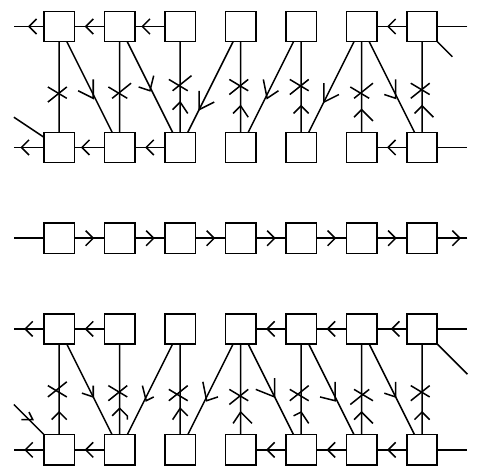
Figure 20 . This is (cid:8) gluing for A theories. The two punctures are of the same sign, opposite orientation, and di(cid:11)erent colors. The puncture symmetry is SU( N ) k . The operators M i are charged under two factors of SU( N ) symmetry. For + boundary conditions they are bifundamental (cid:12)elds and for (cid:0) they are bi-linear operators. For simplicity we have written arrows on some of the lines and the orientation of the rest is determined by the superpotentials we turn for each face of the quiver. In the middle we have the (cid:12)elds we add when gluing, (cid:8), in the bifundamental representation of two of the SU( N ) k symmetries.